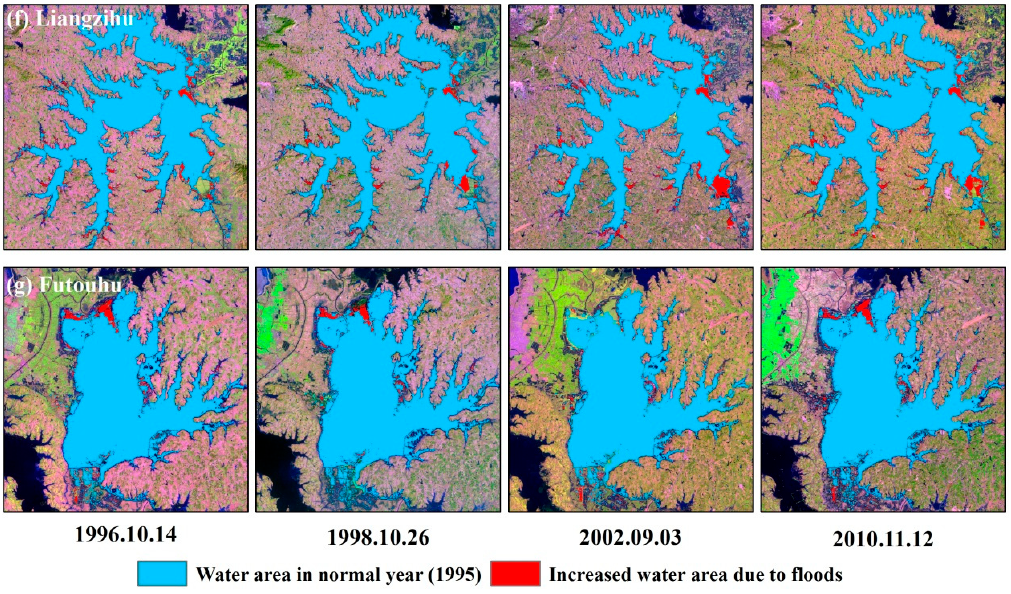
Figure 10. Increased water area due to floods in four periods: 1996, 1998, 2002, and 2010. The lake water area refers to the composited maximum area in the same year.